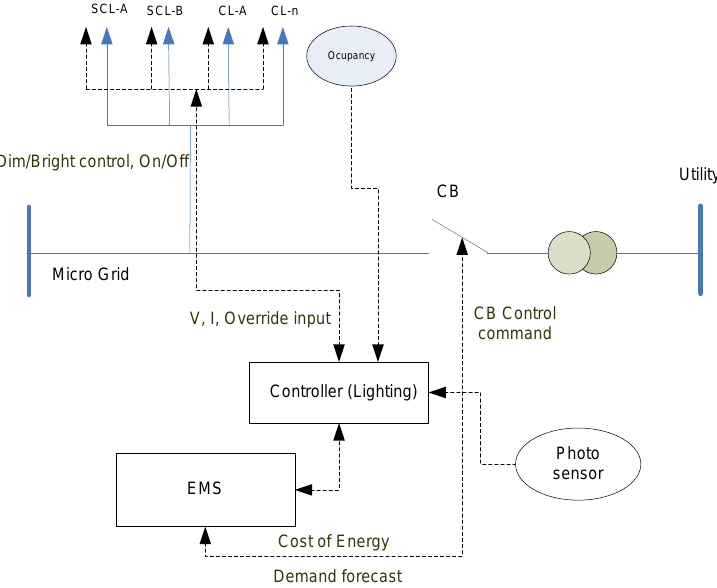
Figure 10. Lighting load control integration with EMS.